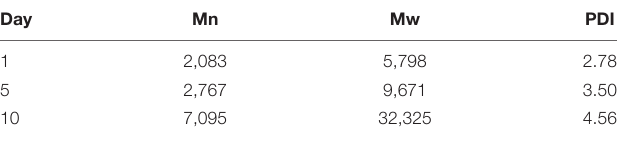
TABLE 4 | Change in molar mass for alkaline biodegradation of